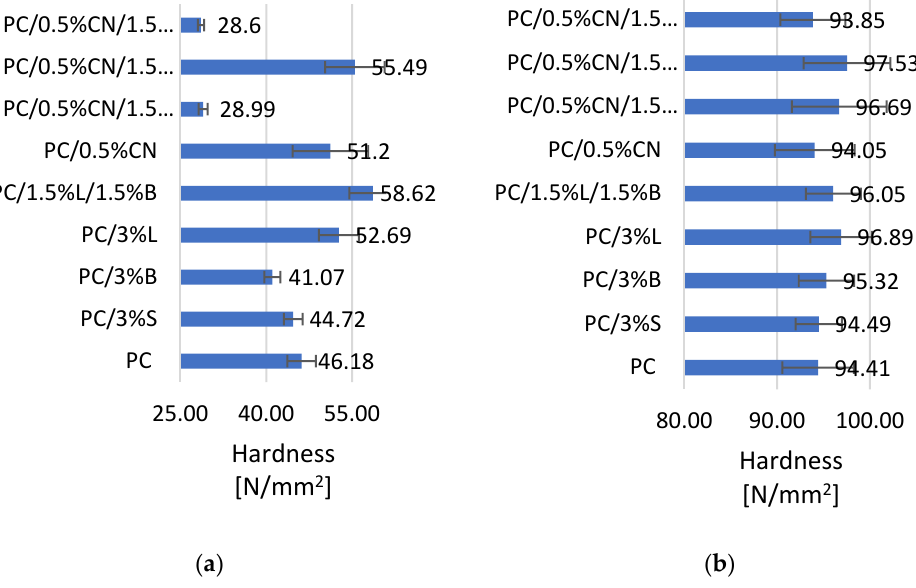
Figure 5. Hardness test results ( a ) samples obtained by 3D printing, ( b ) samples obtained by injection molding. Table 4. Summary of the results of porosity, roughness and dimensional stability tests of samples obtained by 3D